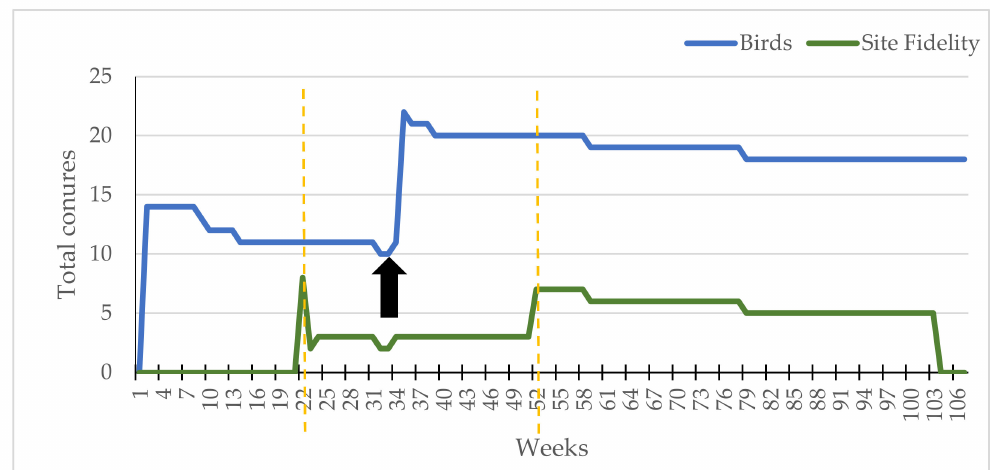
Figure 3. Number of golden conures potentially alive over time (blue) and those that remained near the release site (green); every reduction in the blue line represents a recorded death. The space between the blue and green lines represents the individuals with uncertain fate during a given time. Dashed orange lines mark the first and second release, the arrow points to the first breeding in the wild, in which one individual is added to the total